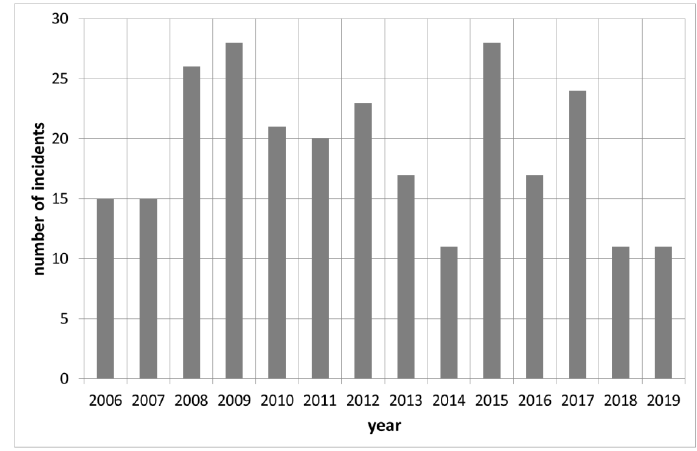
Figure 3. Number of incidents per year (EGIG Pipeline Network).